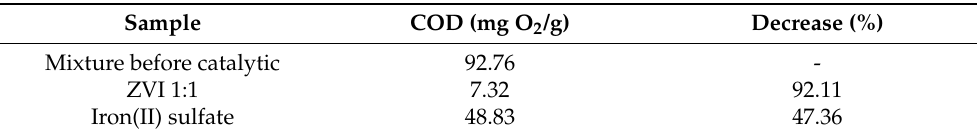
Table 4. COD value measurement results for the mixture of rhodamine B-methyl orange 150 mg/L before and after the Fenton